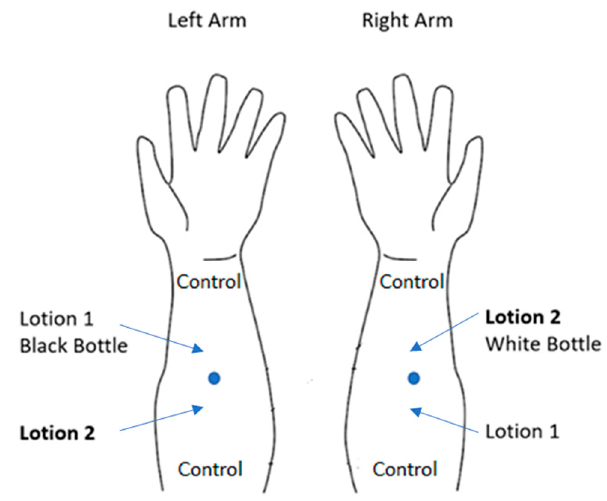
Figure 1. Arrangement of three treatment sites on each arm. Control measurements were taken near the wrist and near the elbow as to generate control measurements.